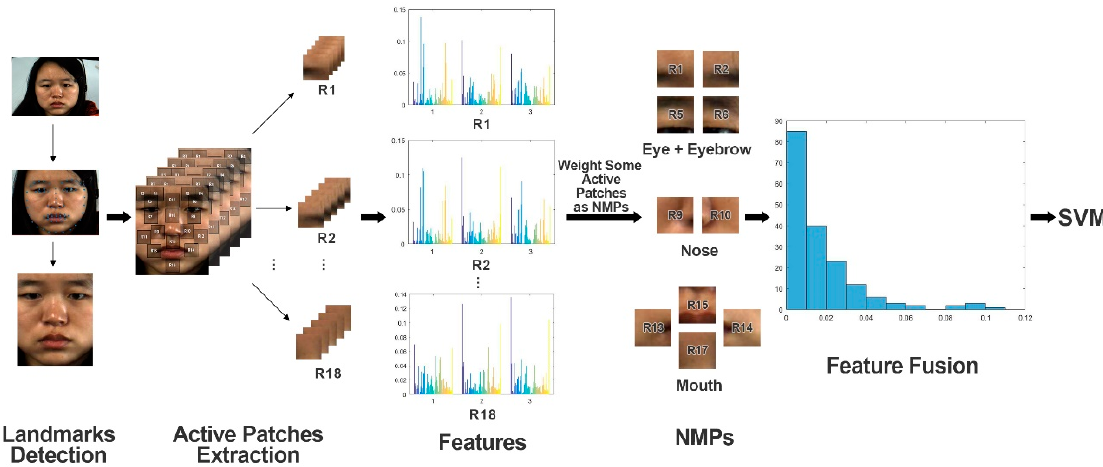
Figure 2. The proposed algorithm framework.